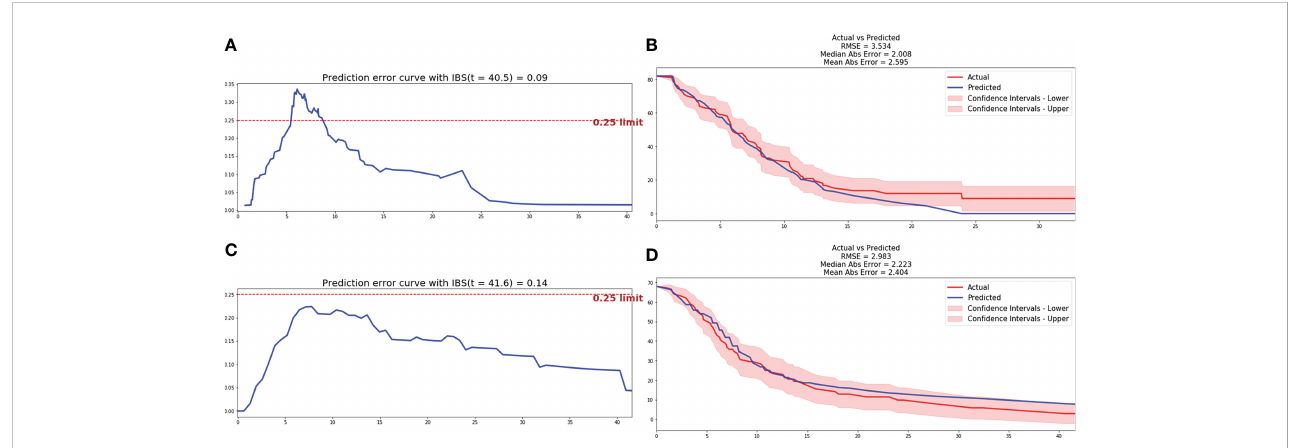
FIGURE 4 Prediction error curve and correction curve of DeepSurv and N-MTLR model. (A) Prediction error curve of DeepSurv model. (B) Prediction error curve of DeepSurv model. (C) Correction curve of N-MTLR model. (D) Correction curve of N-MTLR